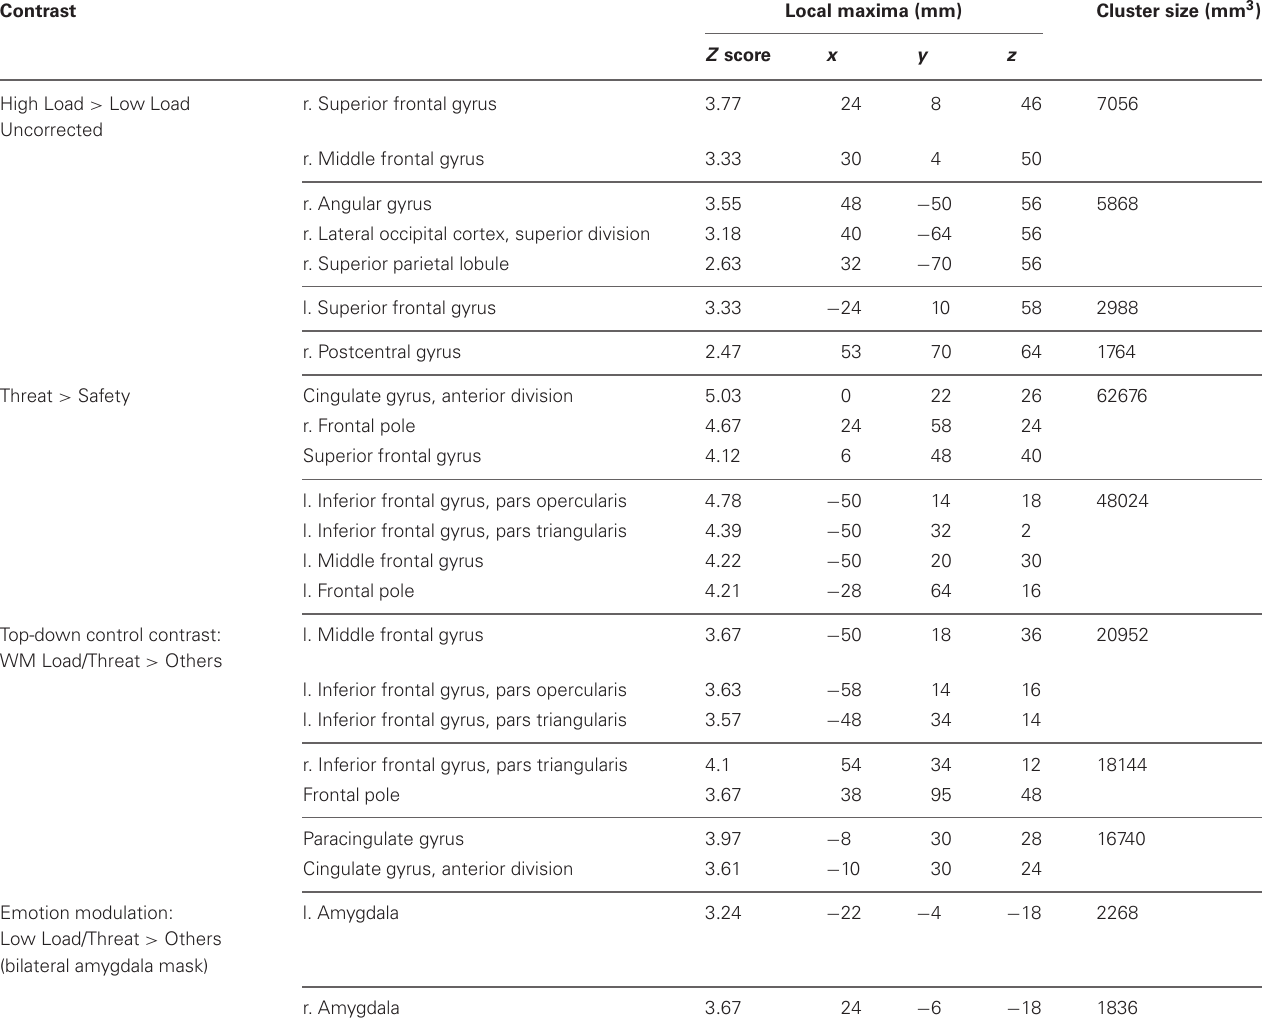
Table 1 | Summary of imaging results for the main effect of WM Load, Threat, and the directed contrasts to investigate top-down control and emotion